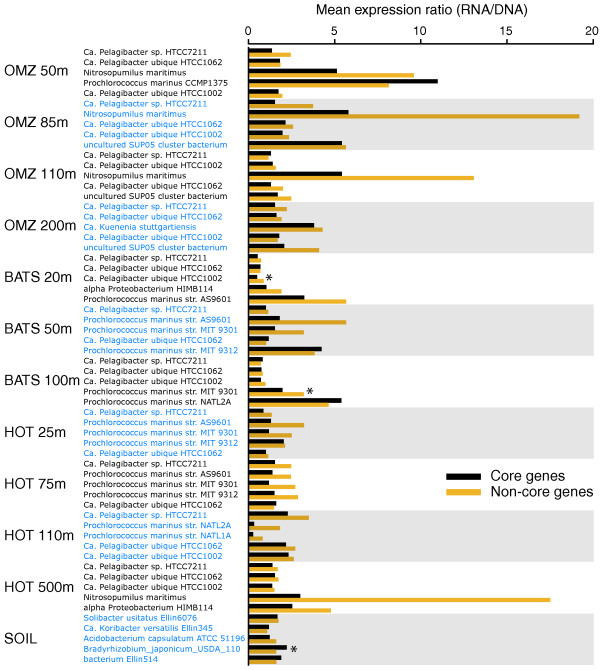
Mean expression level of core and non-core genes across the five most abundant taxa per sample. Per gene expression level is measured as a ratio - (Transcript abundance in RNA sample)/(Gene abundance in the DNA sample) - with abundance normalized to dataset size. 'Core' genes are determined individually for each taxon based on orthology with a closely related sister taxon, as described in the main text. Asterisks mark taxa for which expression ratios differed significantly between core and non-core genes (P < 0.001, t-test).